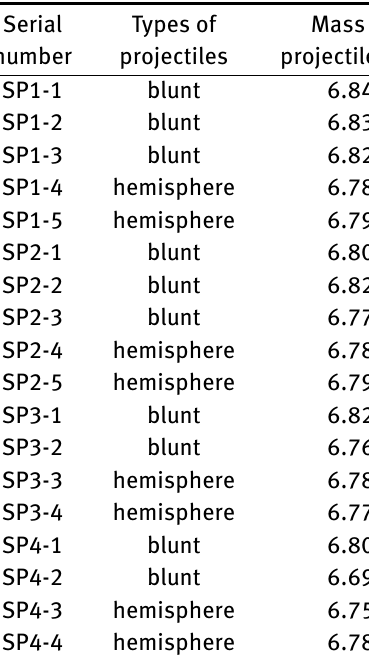
Table 3: Experiential results of sandwich plates by projectiles